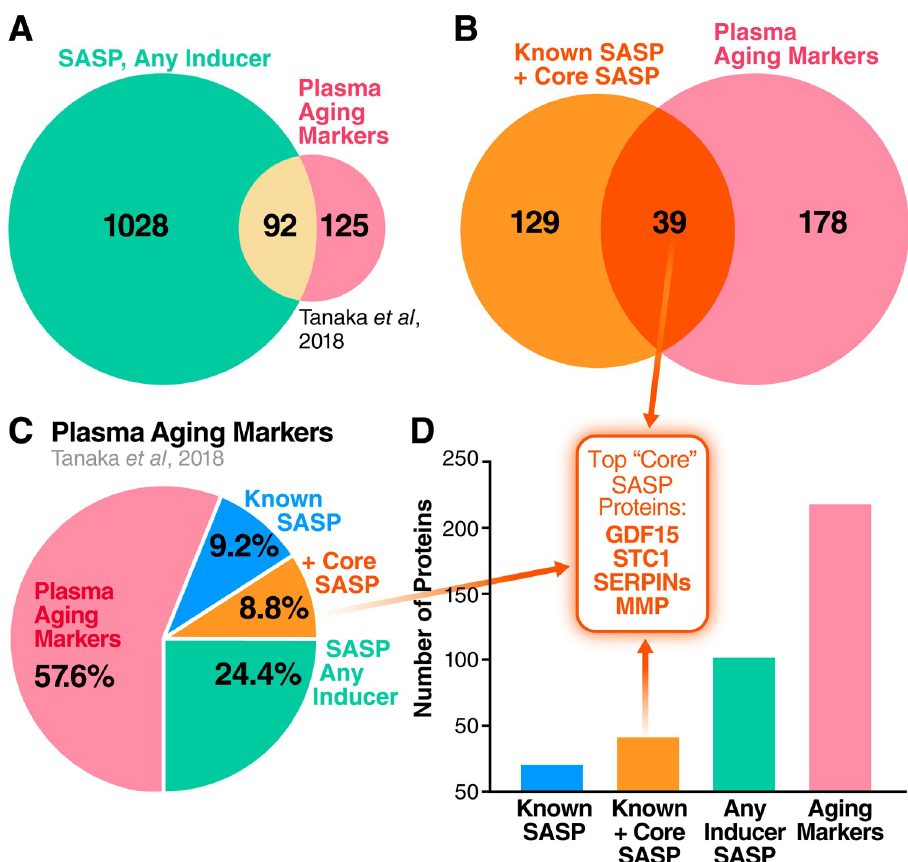
Fig 6. Human plasma aging markers are enriched for sSASP proteins. (A) Venn diagram comparing sSASP factors secreted by at least one of IR-, RAS-, or ATV- induced senescent cells with markers of aging identified in human plasma [48]. (B) Overlap between the core sSASP (proteins secreted following all senescence-inducing stimuli) and plasma aging markers. (C) Pie chart showing the proportion of known sSASP factors, newly identified core sSASP factors, and sSASP factors found among plasma markers of aging in humans. (D) Number of proteins contained in the originally identified sSASP, core sSASP, noncore sSASP, and markers of aging in human plasma [48] ( p < 0.00005). Top core sSASP factors GDF15, STC1, SERPINs, and MMP1 are among the plasma aging markers. ATV, atazanavir treatment; GDF15, growth/differentiation factor 15; IR, X-irradiation; MMP, matrix metalloproteinase; RAS, inducible RAS overexpression; SASP, senescence-associated secretory phenotype; SERPIN, serine protease inhibitors; sSASP, soluble senescence-associated secretory phenotype; STC1, stanniocalcin 1.